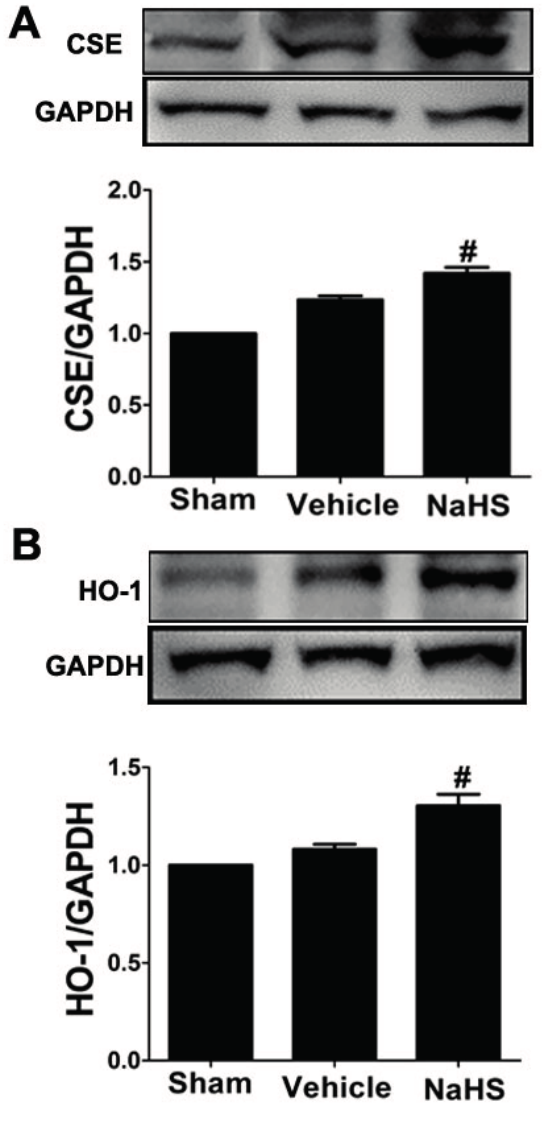
Figure 3. NaHS modulated cystathionine γ -lyase (CSE) and heme oxygenase-1 (HO-1) expression in the border zone of infarcted myocardium. Western blot for ( A ) CSE and ( B ) HO-1 expression. Bar graphs showed quantitative analysis of CSE and HO-1; GAPDH was used as loading control. # p < 0.05 vs . sham-operated rats; n =